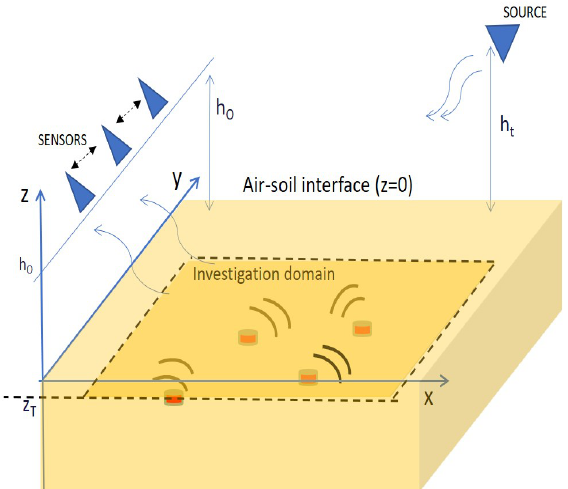
Figure 1. Reference system: the air/soil interface is at z = 0, the investigation plane at z T